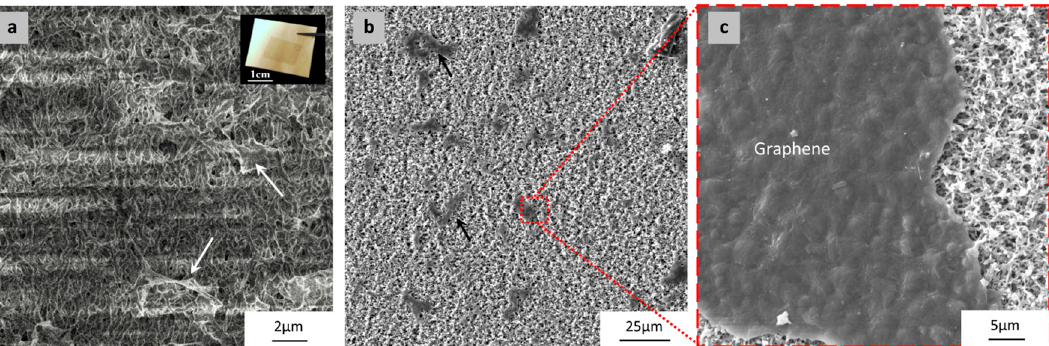
Figure 16. FESEM micrographs of the transferred graphene (~1 × 1 cm 2 ) onto PVDF 6 substrate. ( a ) because the graphene is discontinuous (therefore, unable to conduct away electrons), artifacts are present even at low beam current; ( b ) FESEM of coated graphene/PVDF 6 composite, arrows indicate the discontinuous graphene batches; ( c ) high magnification FESEM micrograph shows one of the graphene domains and the PVDF 6 substrate structure underneath.